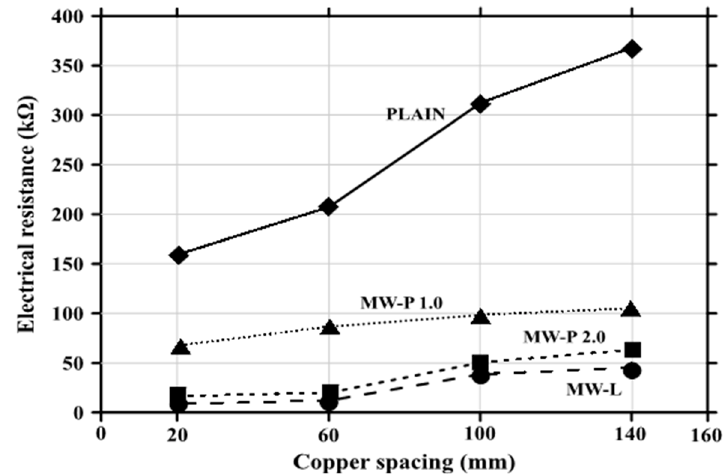
Figure 13. Electrical resistance values according to measurement distance.